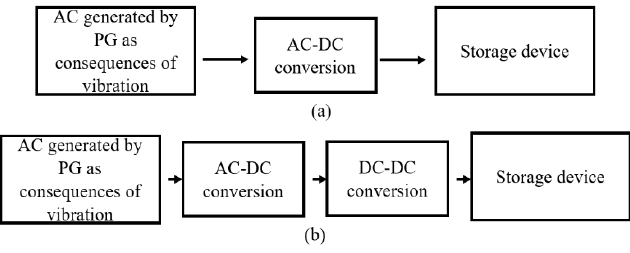
Figure 2. Conversion processes: ( a ) Single, ( b ) Dual stages.